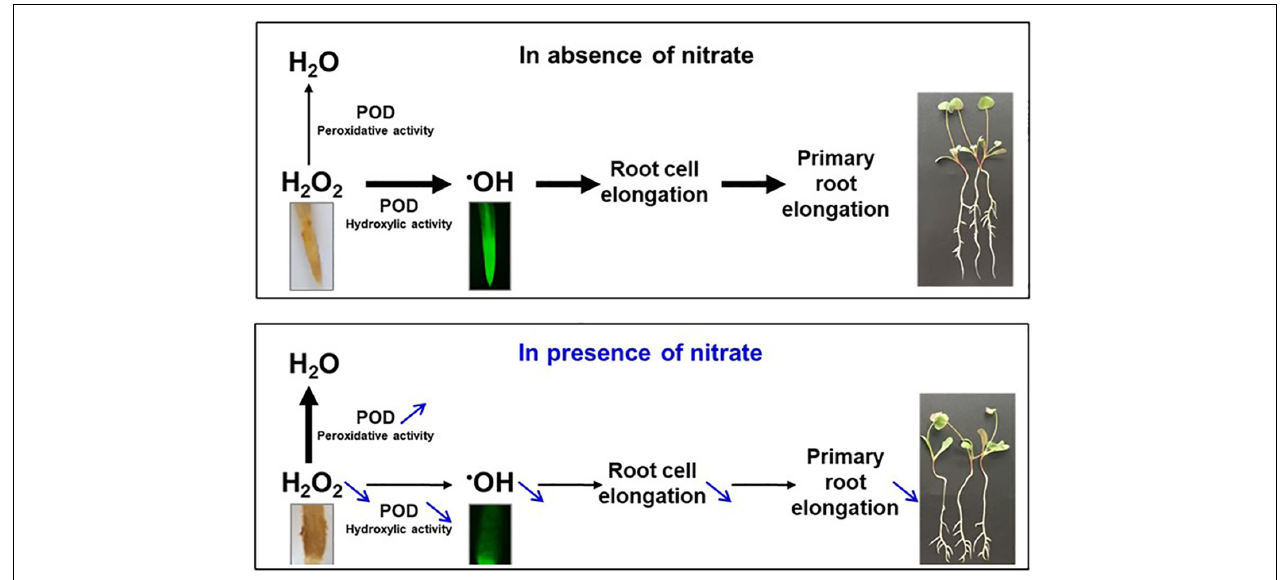
FIGURE 9 | ROS and POD govern primary root growth in M. truncalula . In absence of nitrate (upper panel) , H 2 O 2 accumulated in the primary root tip is for a large part converted by POD hydroxylic activity in • OH, a ROS that favors root cell elongation, and root elongation, through cell wall polymer breaking. H 2 O 2 is also for a smaller part eliminated by POD peroxidative activity, resulting in H 2 O. In the presence of nitrate (lower panel) , both the H 2 O 2 abundance and the POD hydroxylic activity decrease while POD peroxidative activity increases. As a result, • OH is less produced, restricting cell and root elongation. H 2 O 2 and • OH were detected in the root tip with diaminobenzidine (yellow color) and dihydrorhodamine (green fluorescence), respectively. 10-day old seedlings grown in the absence or the presence of 5 mM nitrate are presented at the right of the panels. Adapted from the graphical abstract of Zang et al. (2020).